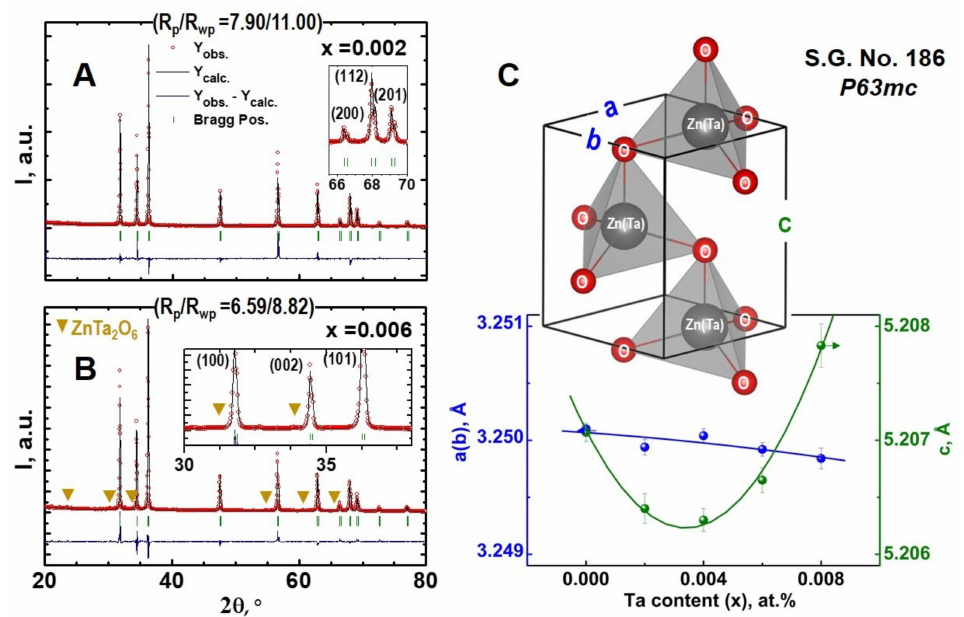
Figure 1. Room-temperature XRD patterns and profile fitting results for nominal Zn 0.998 Ta 0.002 O ( A ) and Zn 0.994 Ta 0.006 O ( B ) compositions; ( C ) wurtzite unit cell and composition dependence of the lattice